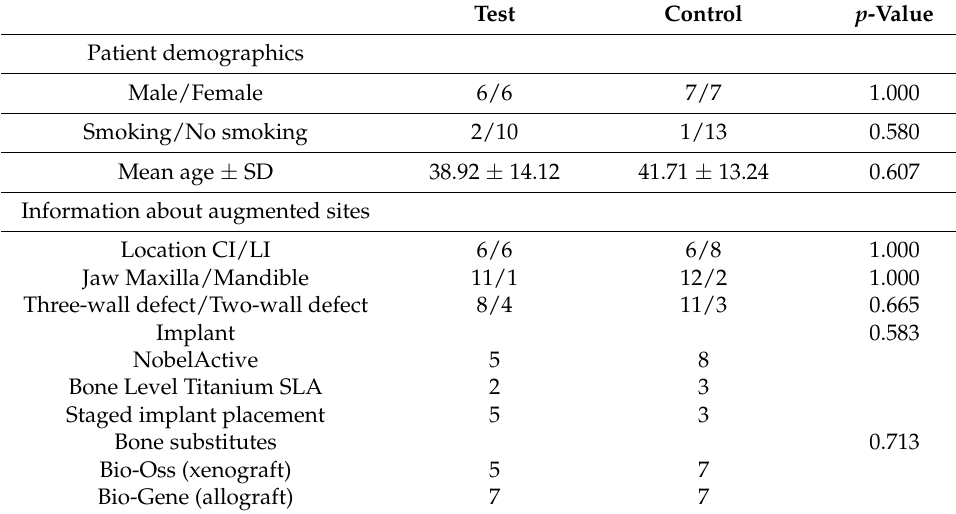
Table 1. Descriptive statistics for each